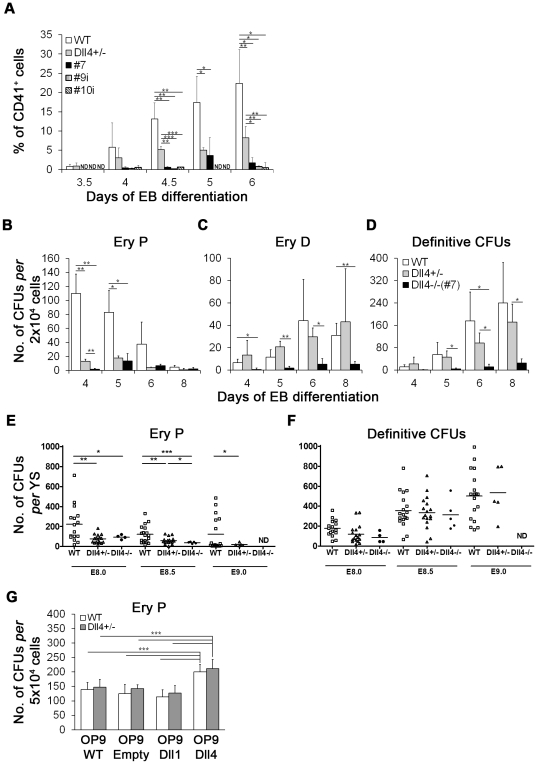
Effects of Dll4 in hematopoiesis.(A) Flow cytometry analysis of CD41 expression in WT, Dll4+/− and Dll4−/− EBs from day 3.5 to day 6 of differentiation. (B) Number of CFU-EryP; (C) CFU-definitive erythroid (EryD) and (D) total definitive CFUs (include CFU-EryD, -macrophage, -granulocyte, -granulocyte//macrophage and -erythroid/granulocyte/macrophage) generated by WT, Dll4+/− and Dll4−/− EB cells at days 4, 5, 6 and 8 of differentiation. (E–F) Number of CFU-EryP (E) and total definitive CFUs (F) generated by YS cells from WT, Dll4+/− and Dll4−/− mouse embryos at E8.0, E8.5 and E9.0. Each symbol represents individual YS and horizontal lines indicate the mean value. (G) Number of CFU-EryP generated by WT and Dll4+/− cells at day 5 of differentiation on parental OP9 cells (OP9-WT) or OP9 cells transduced either with retroviral vectors containing Dll4 (OP9-Dll4), Dll1 (OP9-Dll1) or only IRES-eGFP sequences (OP9-Empty). ND not determined. *P<.05, **P<.01, ***P<.001.